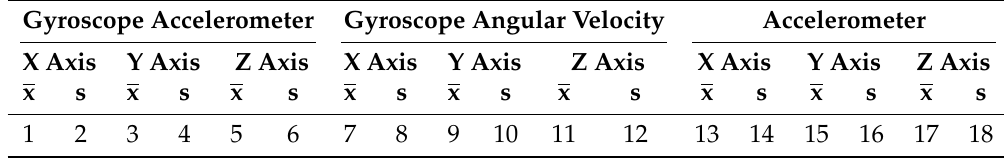
Table 3. Feature vector structure (Fields 1 to 18).